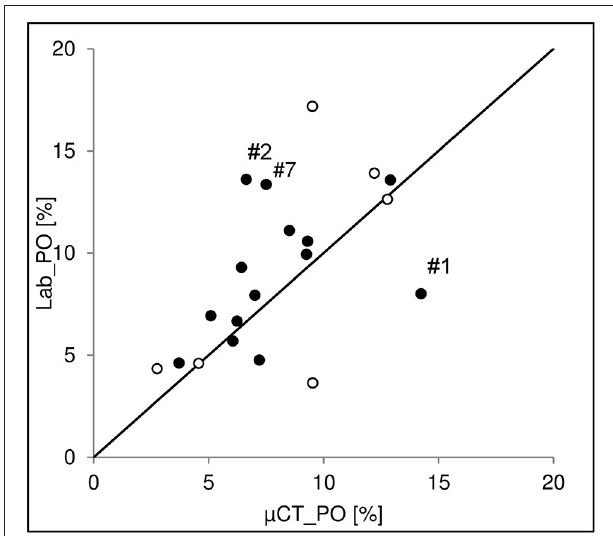
FIGURE 2 | Air-filled porosity measured in the laboratory at a water matric potential of − 1 kPa (Lab_PO) vs. the visible porosity measured on X-ray images ( µ CT_PO) for the calibration data set (black circles) and the validation data set (white circles).